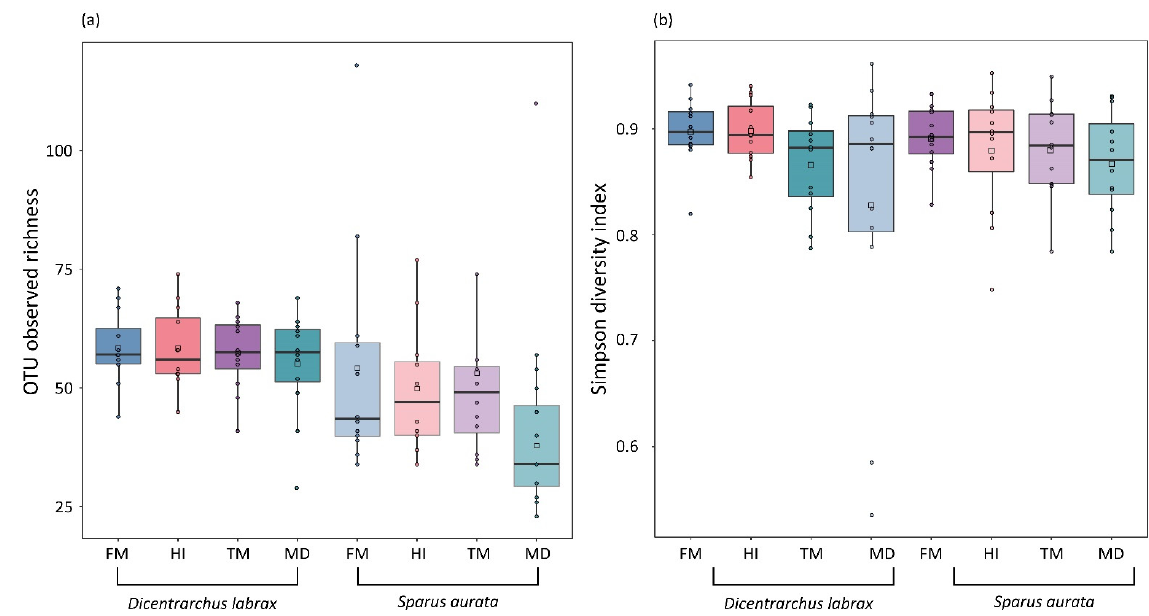
Figure 2. Scattered boxplots of ( a ) observed bacterial OTU richness and ( b ) Simpson reciprocal index (1-D) of gut microbiota among Dicentrarchus labrax and Sparus aurata fed control (FM) and insect-containing diets (HI, TM, MD). Abbreviations according to Figure 1.